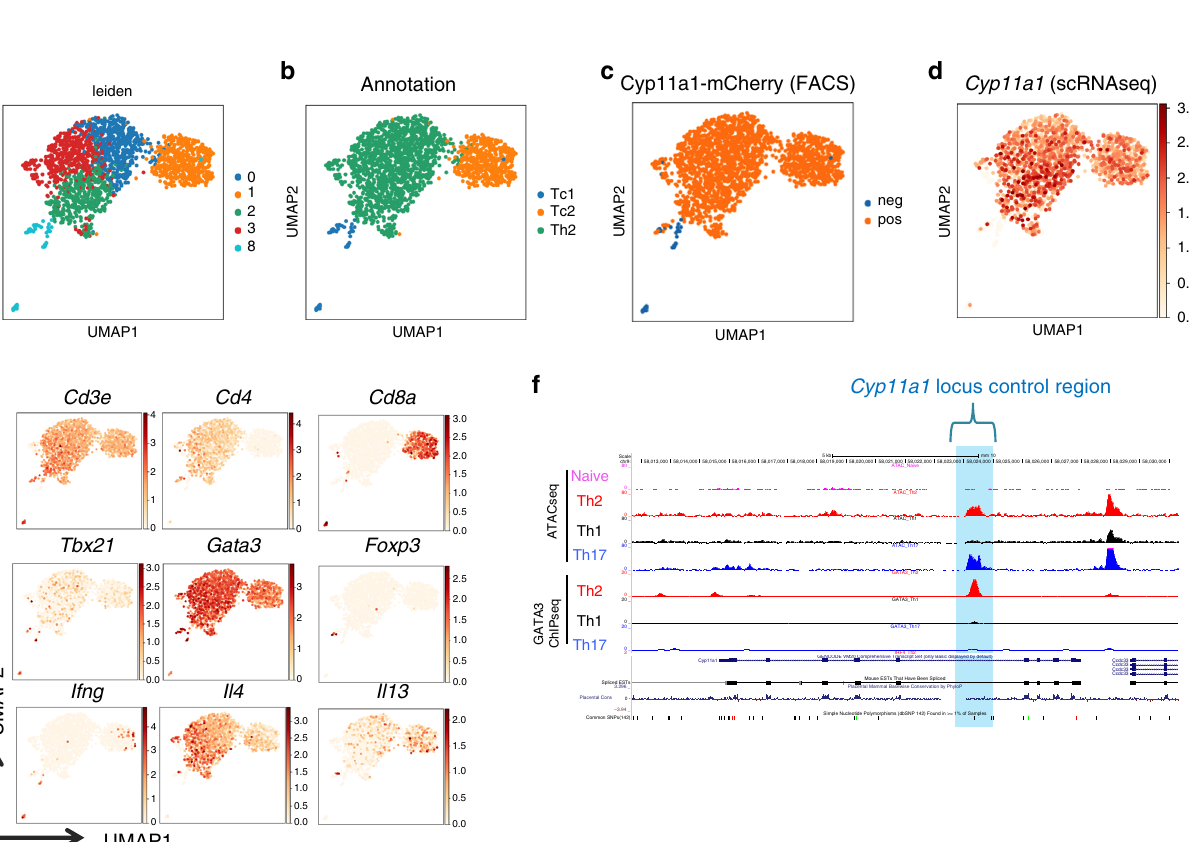
Fig. 3 Tumors induce Cyp11a1 expression in T cells in vivo. a B16-F10 cells were injected subcutaneously into the Cyp11a1 -reporter mice. After 12 days brachial lymph node (LN), blood, and tumor tissues were analyzed by fl ow cytometry. Gating strategy: Singlets>Live cells>CD45,Cyp11a1-mCherry. N = 5. CD45 + Cyp11a1-mCherry + cells were further gated to show T helper cell (CD4 + CD3e + ) expression of Cyp11a1. b Splenic cells were puri fi ed from tumor- bearing Cyp11a1 -reporter mice, and restimulated in vitro using PMA/ionomycin and analyzed by fl ow cytometry. N = 9. c , d B16-F10 cells were injected subcutaneously into the Cyp11a1-mCherry reporter mice. After 5, 7, and 12 days tumor tissues were analyzed by fl ow cytometry to detect the CD4 + T cells ( c ), CD8 + T cells ( d ) N = 4. All cell>Singlets>Live cell>CD45 + >CD4 + CD3e + or CD8 + CD3e + . e – g EO771 cells were injected into the mammary fat pad of Cyp11a1 -reporter mice. After 15 days, tumor tissues and tumor-draining LN were analyzed by fl ow cytometry to detect the Cyp11a1-mCherry expression in